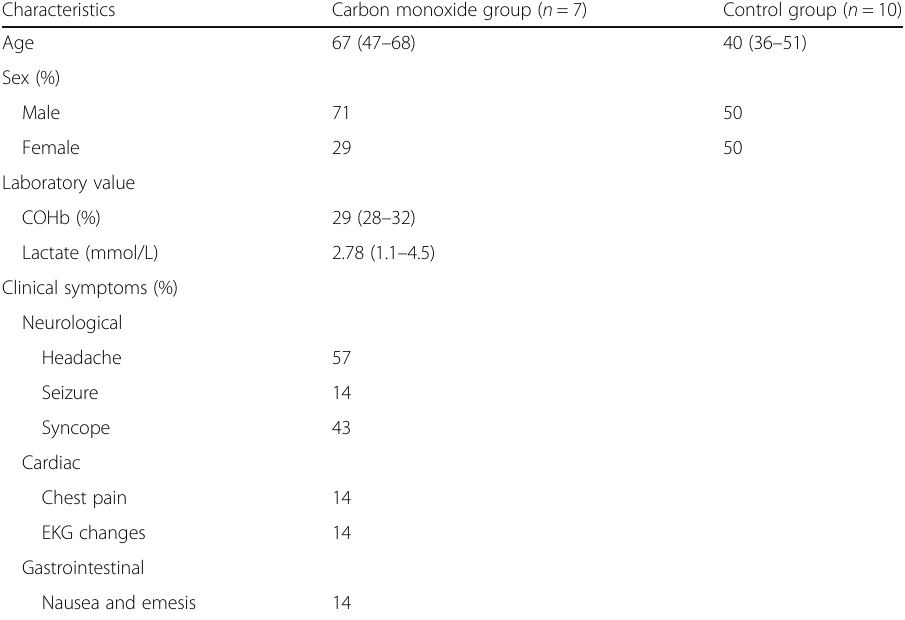
Table 1 Characteristics of subjects in the CO and control group